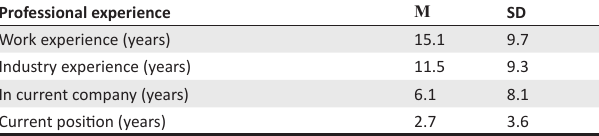
TABLE 1b: Characteristics of